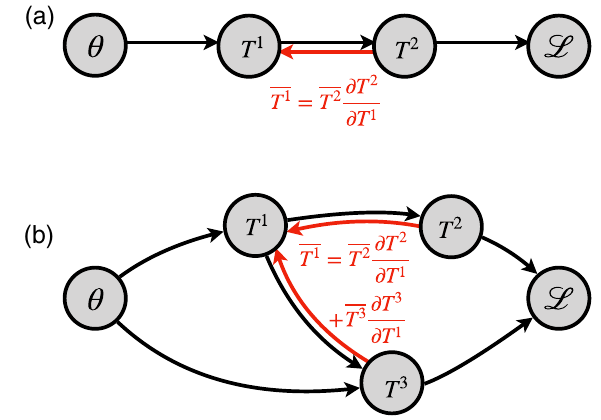
FIG. 1. Reverse-mode automatic differentiation on computation graphs. Black arrows indicate the forward function evaluation from inputs to outputs. Red arrows indicate backward steps for adjoint backpropagation. (a) A chain graph. (b) A more general computation graph. In the backward pass, the adjoint of a given node is computed according to Eq.